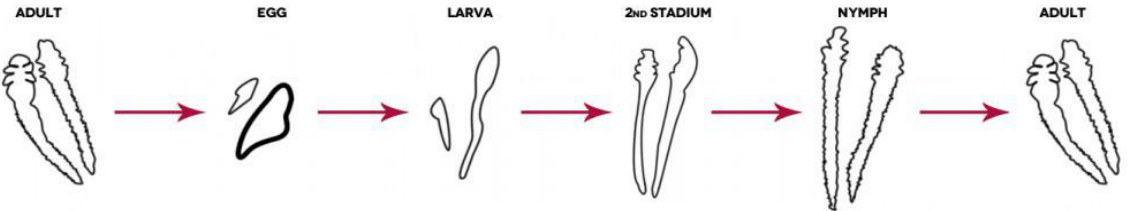
Figure 1. Life cycle of the Demodex mite.